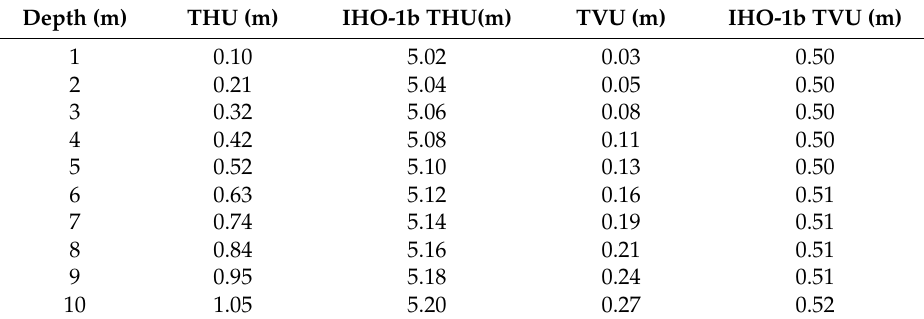
Table 5. Comparison of the estimated THU and TVU values (2 σ ) obtained from the Monte Carlo simulations based on the empirical refraction angle standard deviation values obtained from 20 ◦ incidence angle and 5.25 m/s wind